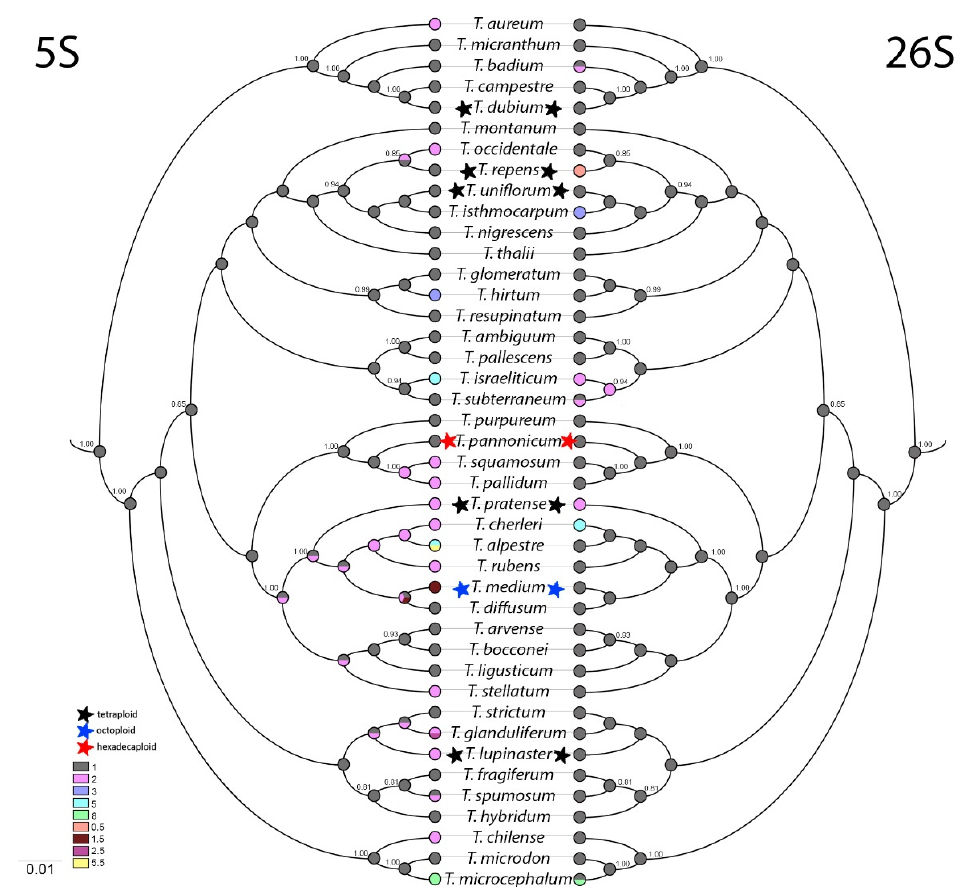
Figure 3. Ancestral state reconstruction of 5S ( left ) and 26S ( right ) rDNA sites numbers. ITS1 spacer of dicotyledon A. thaliana was chosen as the root of the tree and then omitted from the final visualization. Stars mark polyploids. Colour charts represent numbers of 5S and 26S rDNA sites per haploid genome.